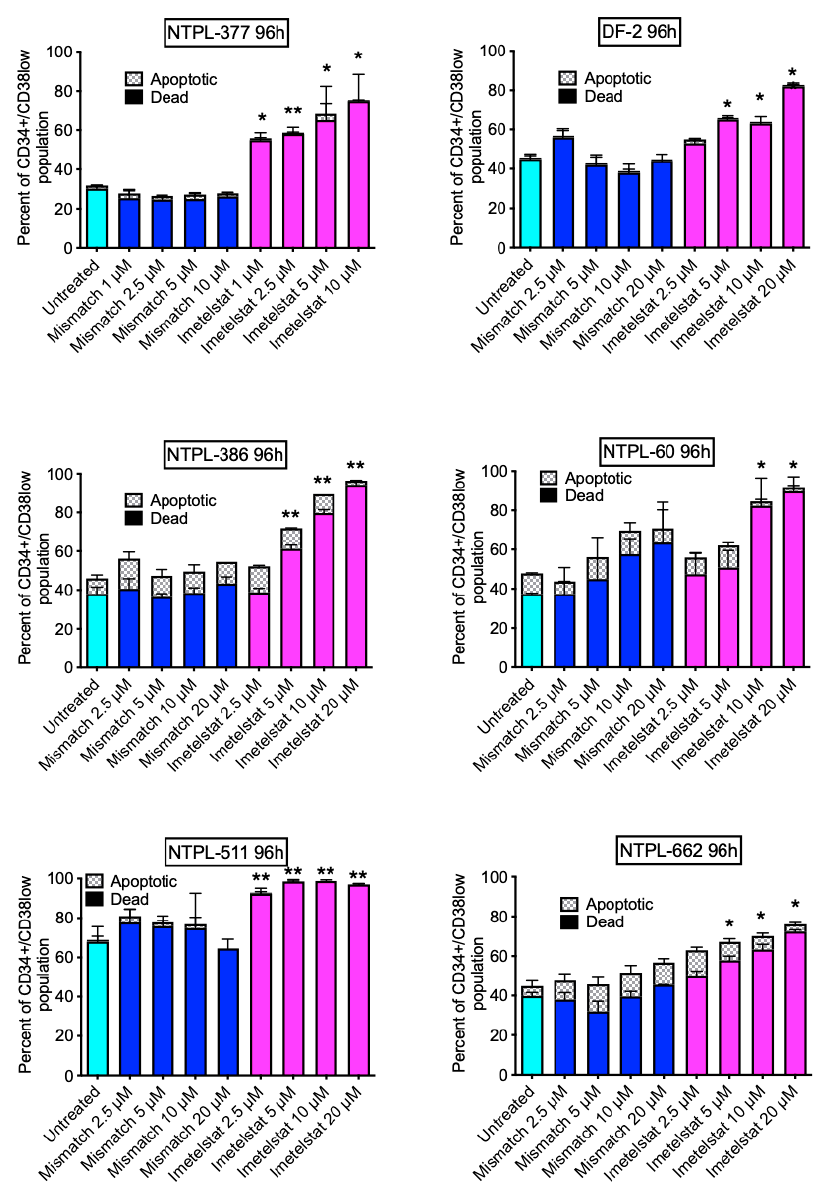
Figure 1. Imetelstat increased the percentage of dead cells in the LSC population in a dose-dependent manner in six pediatric AML PDX lines developed from diagnostic specimens (except DF-2, which was generated from a sample procured at relapse). Error bars denote SE of the mean from 2 independent experiments in triplicates. * p < 0.05, ** p < 0.01 comparing imetelstat treated cells to mismatch-treated cells at corresponding concentrations.